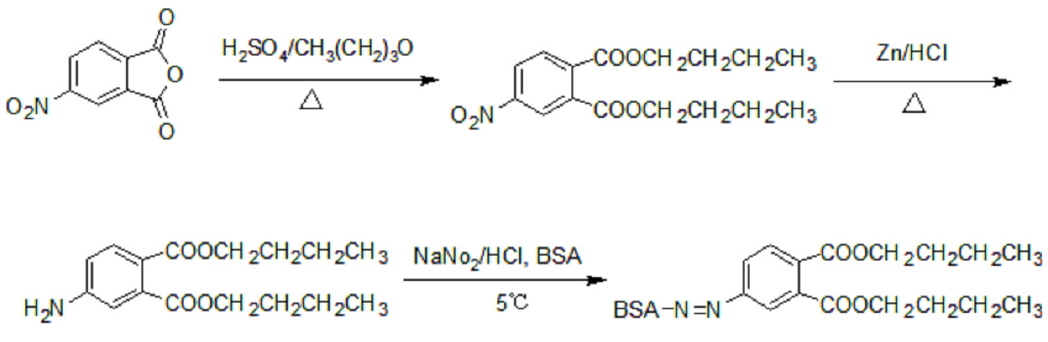
Figure 1: The synthetic route of